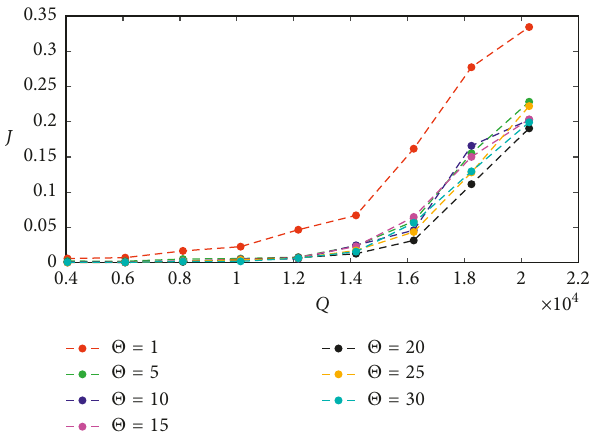
Figure 15: The influence of tunable parameter Θ